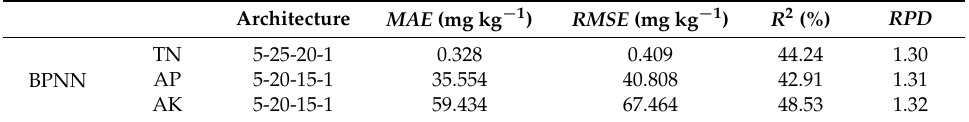
Table 5. The prediction results of soil nutrients using back-propagation neural network (BPNN) model.